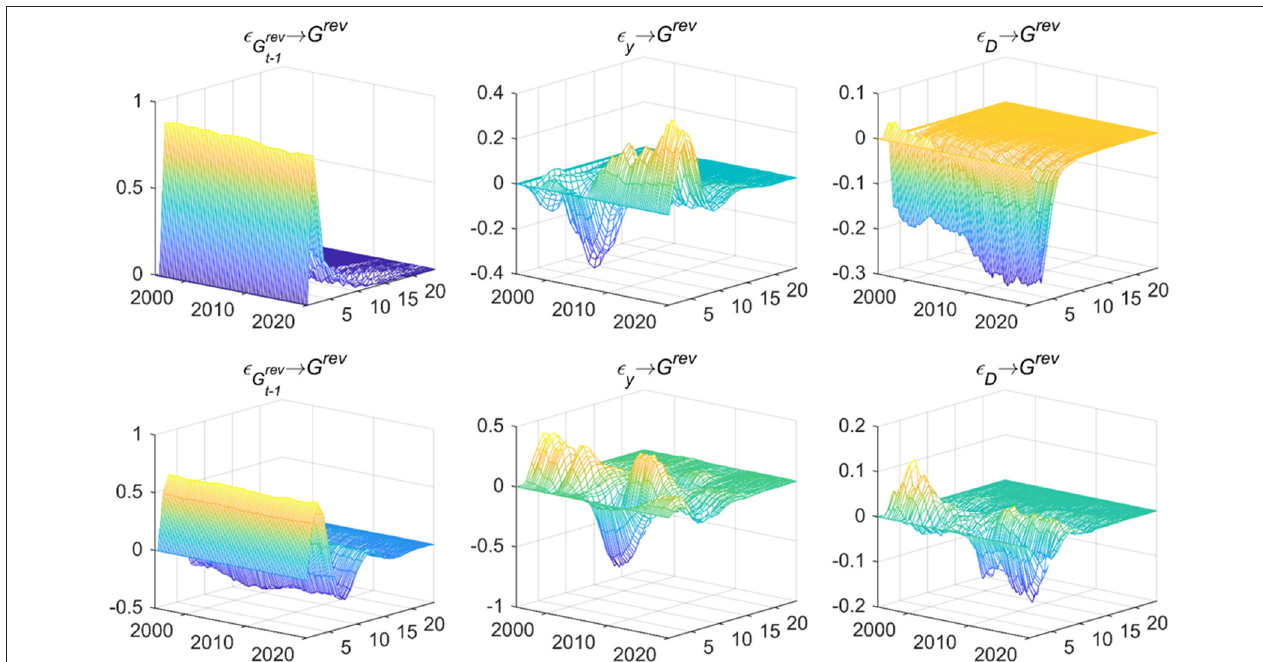
FIGURE 2 | Dynamic feedback on fiscal policy rules. Each subfigure with the title of “ X → Y ” demonstrates the response of variable Y to an orthogonalized positive shock of variable X. In other words, X is an impulse variable, and Y is a response variable. One period in the figure denotes one season.